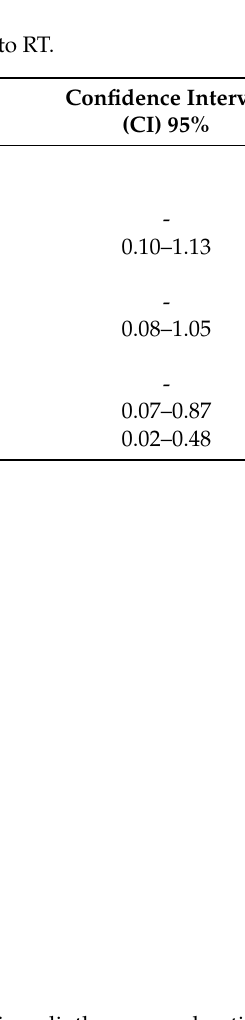
Figure 4. Survival according to response rate obtained with hepatic radiotherapy and anti-PD-1. PR: partial response (37.5 months, solid line); SD: stable disease (30.1 months, dashed line); PD: progres- sive disease (15.2 months, dotted line).